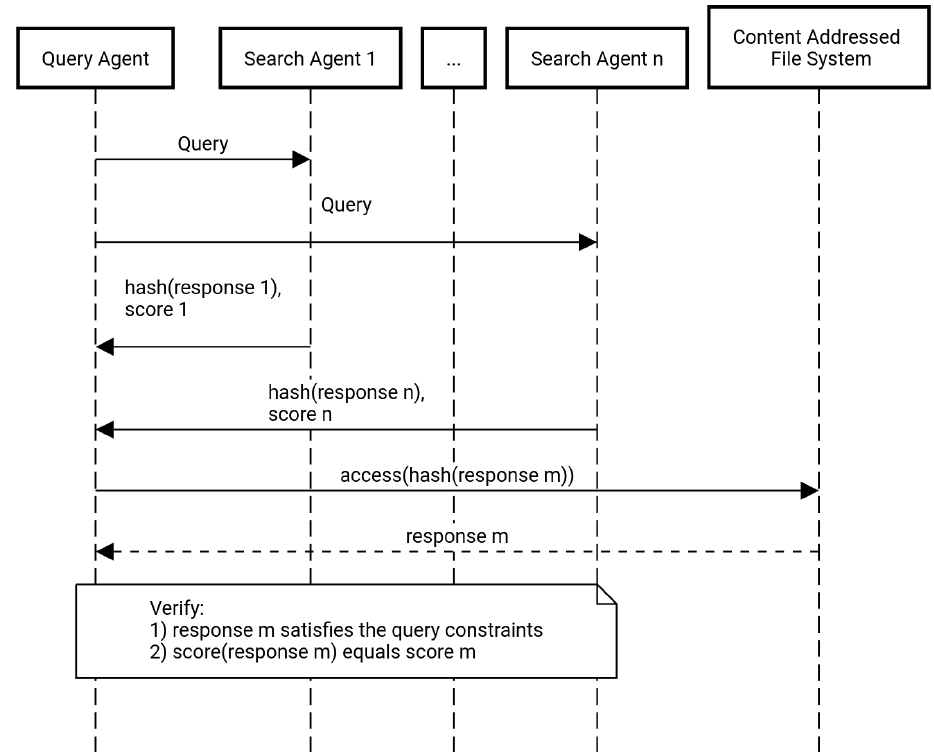
Figure 4. Distributed discovery protocol UML sequence